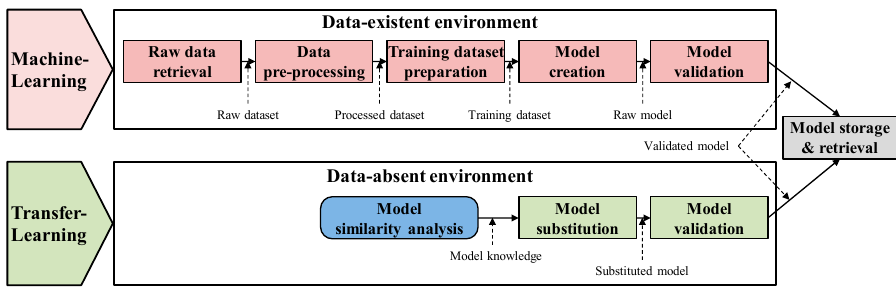
Figure 4. The modeling method of a hybrid-learning approach